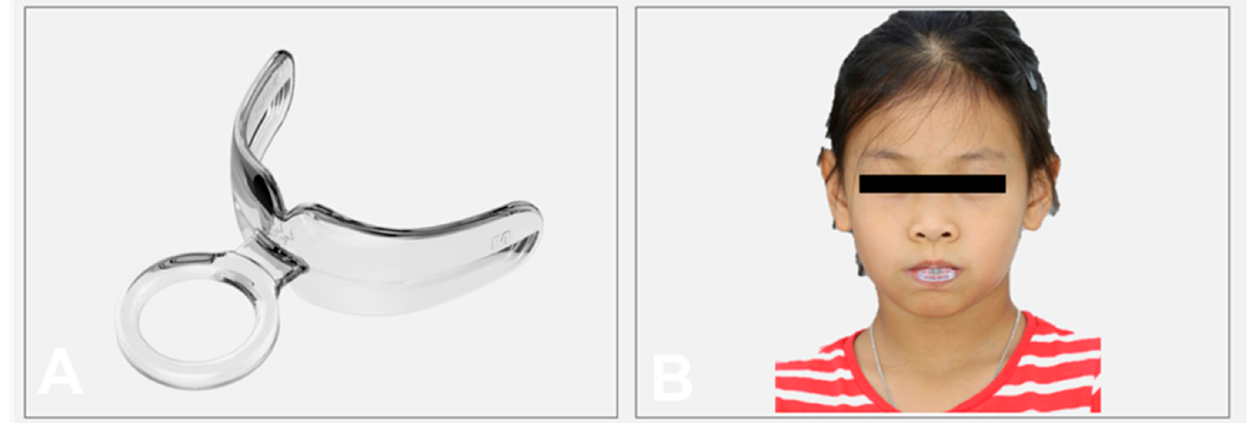
Figure 1. The treatment mechanisms of NOA™-F3 for anterior crossbite. ( A ): Procline upper incisors (red arrow), retrocline lower incisors (blue arrow), and guide mandible backward (brown arrow) and scissor bite. ( B ): Lingually moving maxillary posterior teeth (red arrow), buccally uprighting mandibular posterior teeth (blue arrow), and guide mandible to the left side (brown arrow).